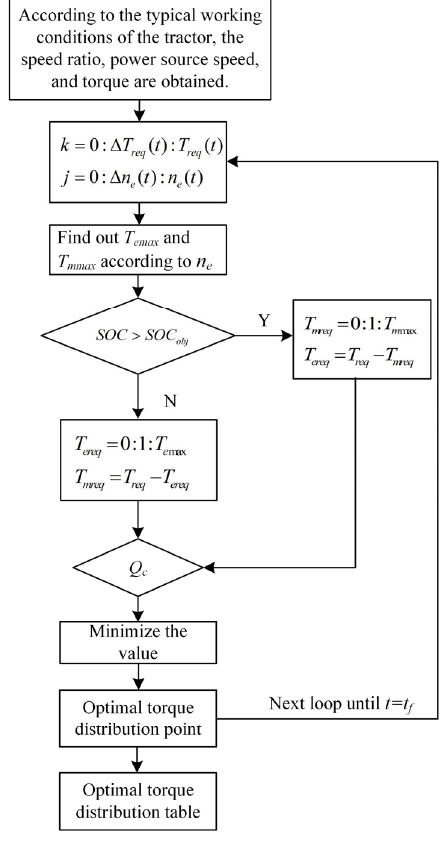
Figure 6. The flowchart of optimal torque distribution table solves.